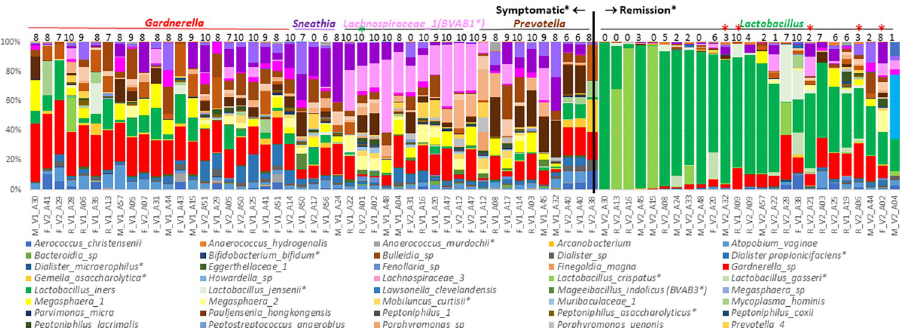
Fig 4. Manual clustering of patient samples by their most abundant genus (MAG). Relative abundances of genera were plotted as a stacked barchart in Excel and sorted by the 5 most MAG’s, color coded as shades of their title fonts. Within each group, samples were sorted by relative abundance of the MAG. Nugent scores are displayed above each sample. � : exceptional sample, Amsel-negative but non- Lactobacillus MAG sample. � : exceptional